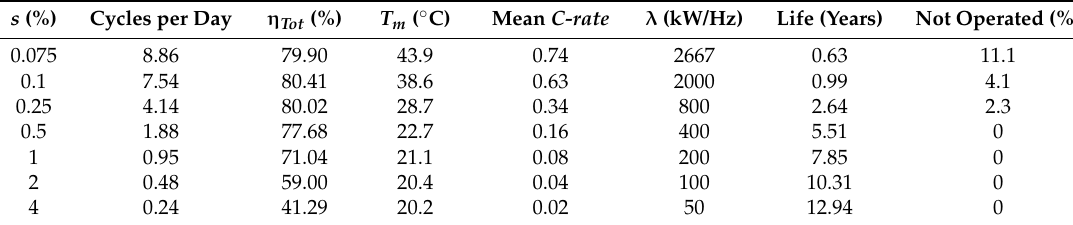
Table 6. PFC results: C-rate = 2C, T 0 = 20 ◦ C.